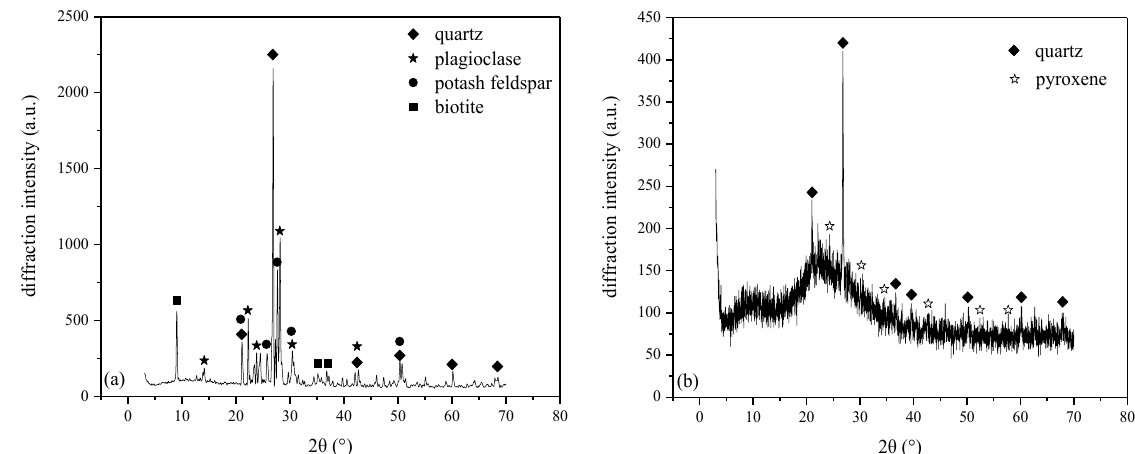
Figure 5. XRD curve of ( a ) original specimen and ( b ) molten graphite.